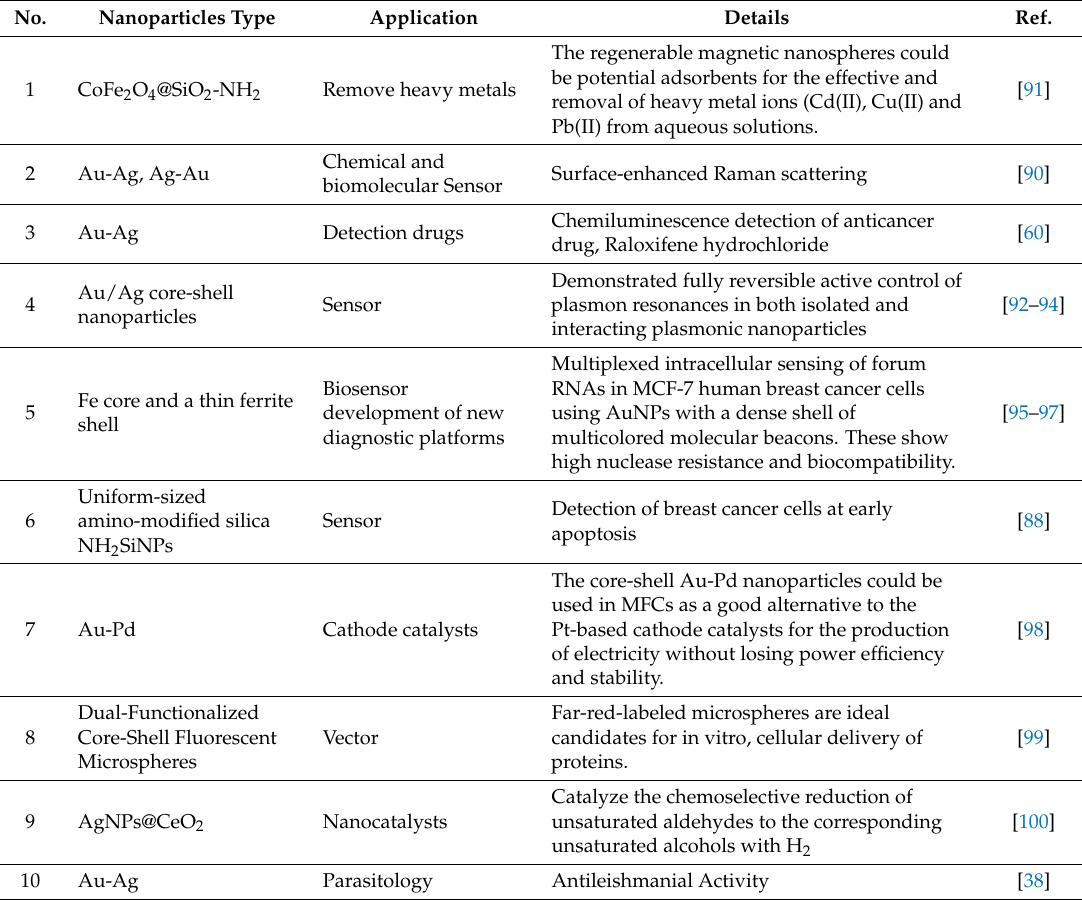
Table 4. Some applications of core shell nanoparticle in various scientific